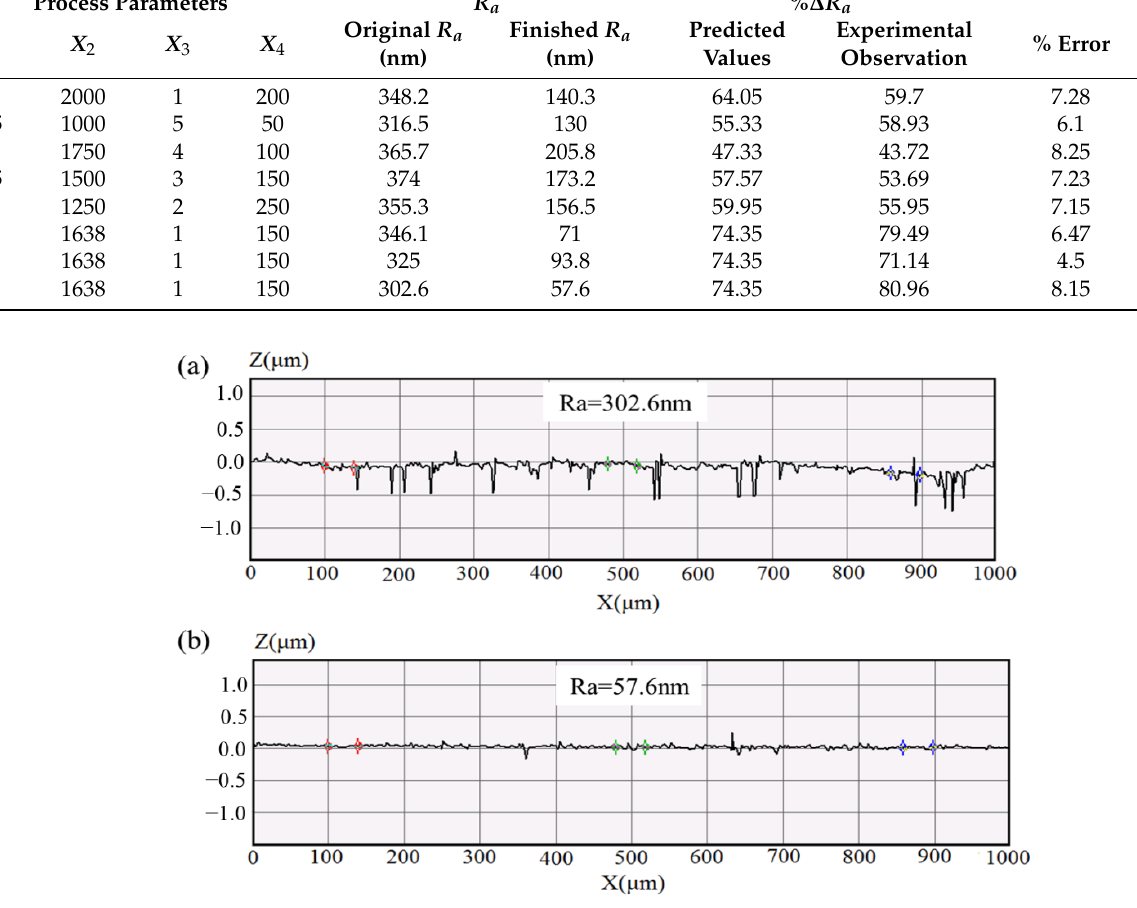
Figure 13. Surface roughness for ( a ) original surface; ( b ) finished surface when using 1 mm working gap, 1638 rpm, 1 mm/min feed rate and 150 mesh.